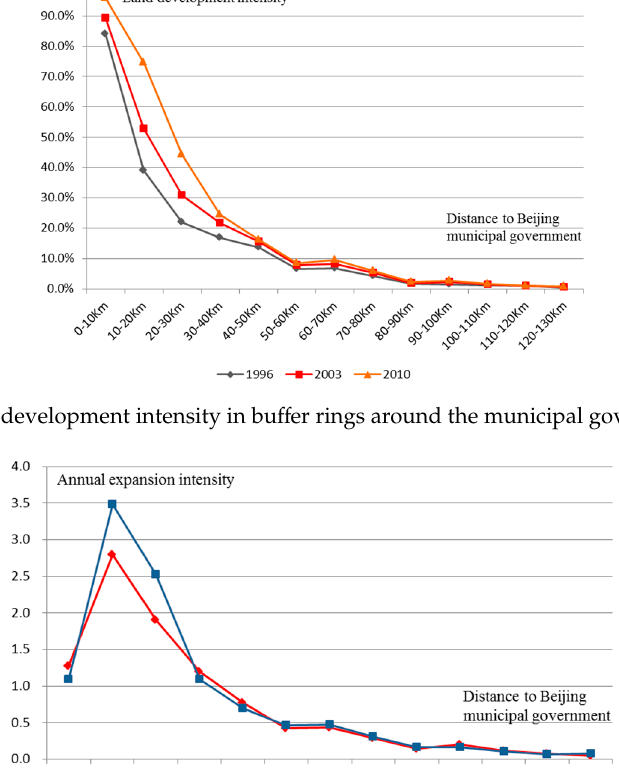
Figure 6. The land development intensity in buffer rings around the municipal government in Beijing.